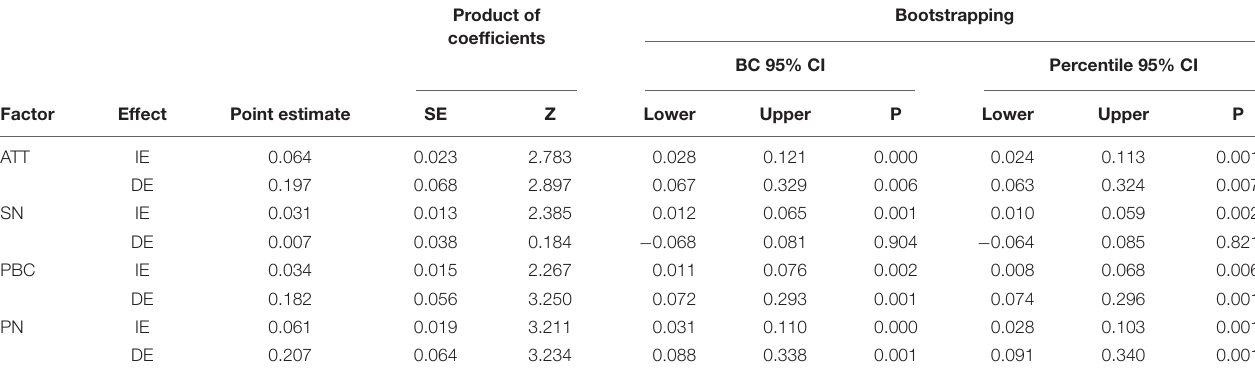
TABLE 4 | Mediating effect results.